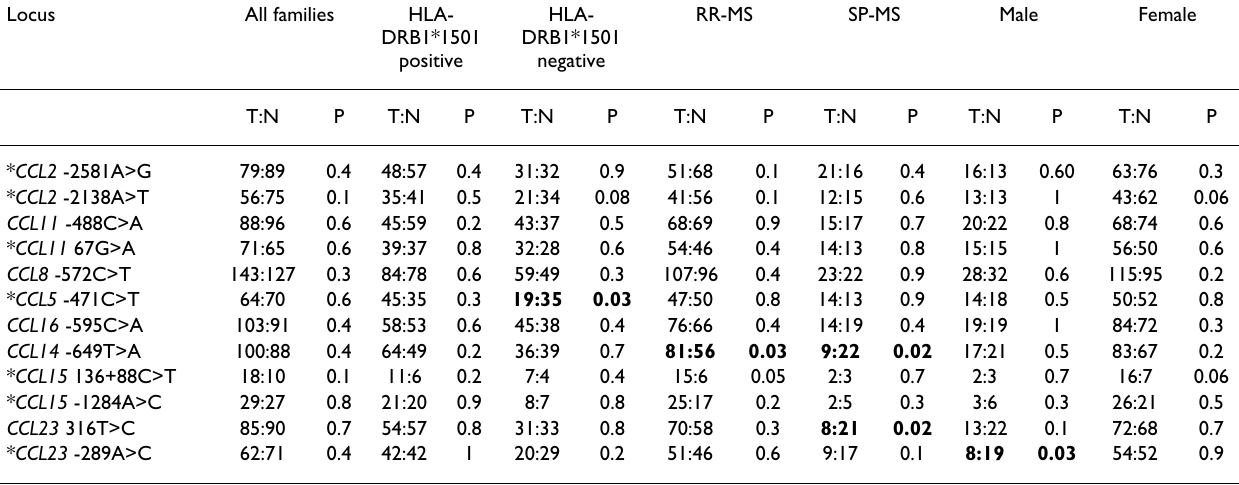
Table 3: Single locus TDT analysis of individually genotyped CC chemokine gene markers. Locus All